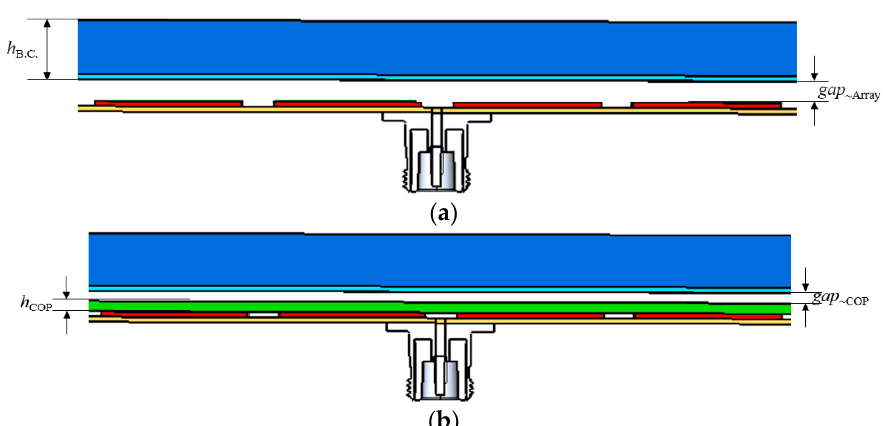
Figure 6. The loading of the back − cover and COP film with the resonator array. ( a ) Back − cover above the array. ( b ) Array contacting the COP film below the back − cover. the array. ( b ) Array contacting the COP film below the